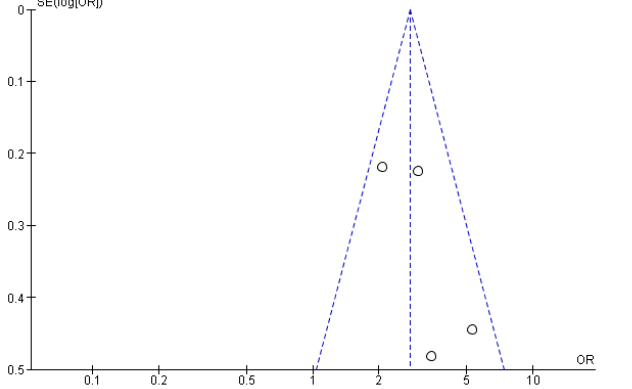
Figure 4. Forest plot and funnel plot of the association between the risk of PB with LBW in newborns with PD in pregnant women.